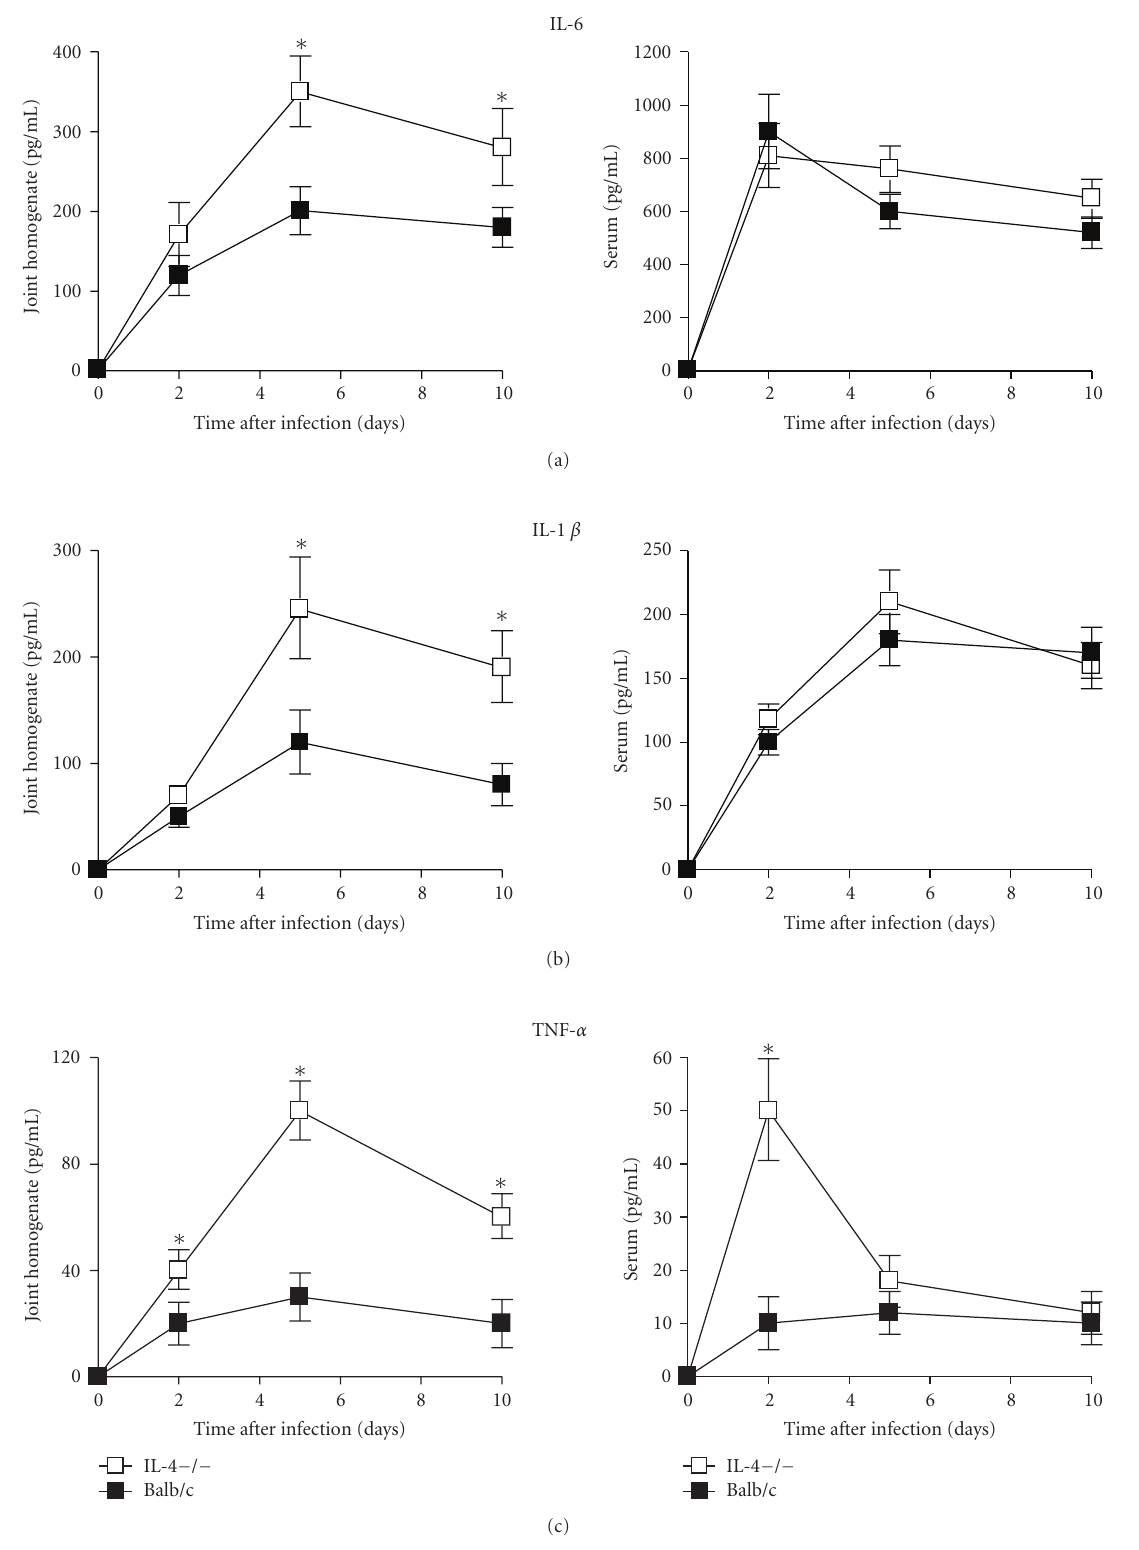
Figure 4: Cytokine production in joints, and sera . IL-4-deficient or wt mice infected with 1 × 10 7 GBS/mouse. Supernatants from joint homogenates, or blood samples were collected at the indicated times after infection and assayed for TNF- α , IL-6, and IL-1 β by ELISA as detailed in materials and methods (see Section 2). Values are the mean ± SD of three separate experiments each consisting of 20 mice per experimental group. Three mice per group were sacrificed at each time point. Statistical di ff erences between the experimental groups were marked with asterisk ( P < .